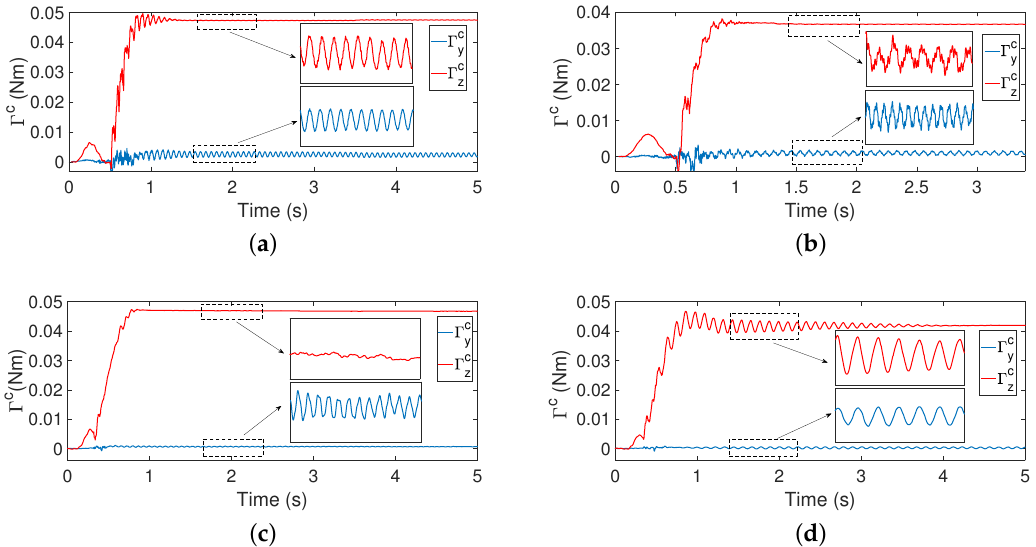
Figure 20. Experimental torques during the estimation process: ( a ) azimuthal movement with contact point in 0.4 m, ( b ) azimuthal movement with contact point in 0.7 m, ( c ) elevation movement with contact point in 0.4 m and ( d ) elevation movement with contact point in 0.7